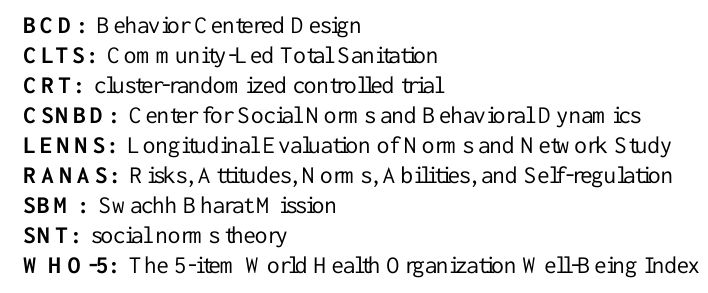
WHO-5: The 5-item World Health Organization Well-Being